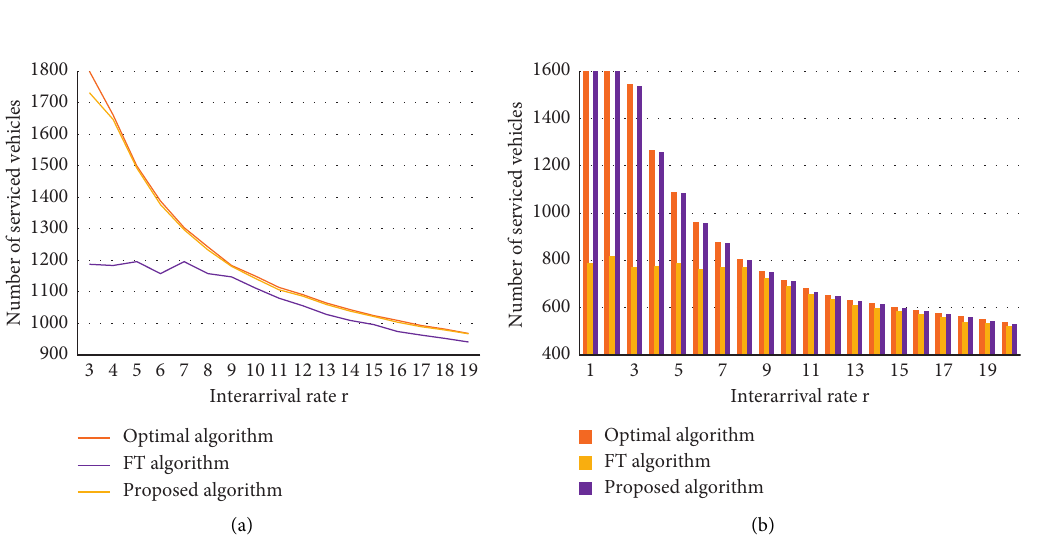
Figure 11: The number of serviced vehicles using the optimal algorithm, the fixed-time (FT), and the proposed algorithm (PA) when varying the rates of one road. (a) Different constant rates on the other three roads (10, 15, 20). (b) All the other roads have the same rate (30).